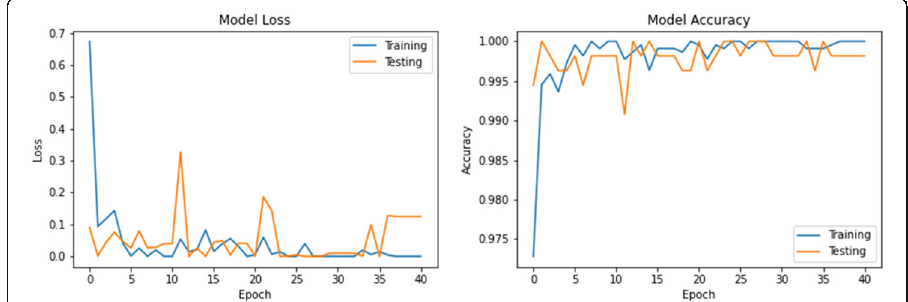
Fig. 8 VGG16 accuracy loss